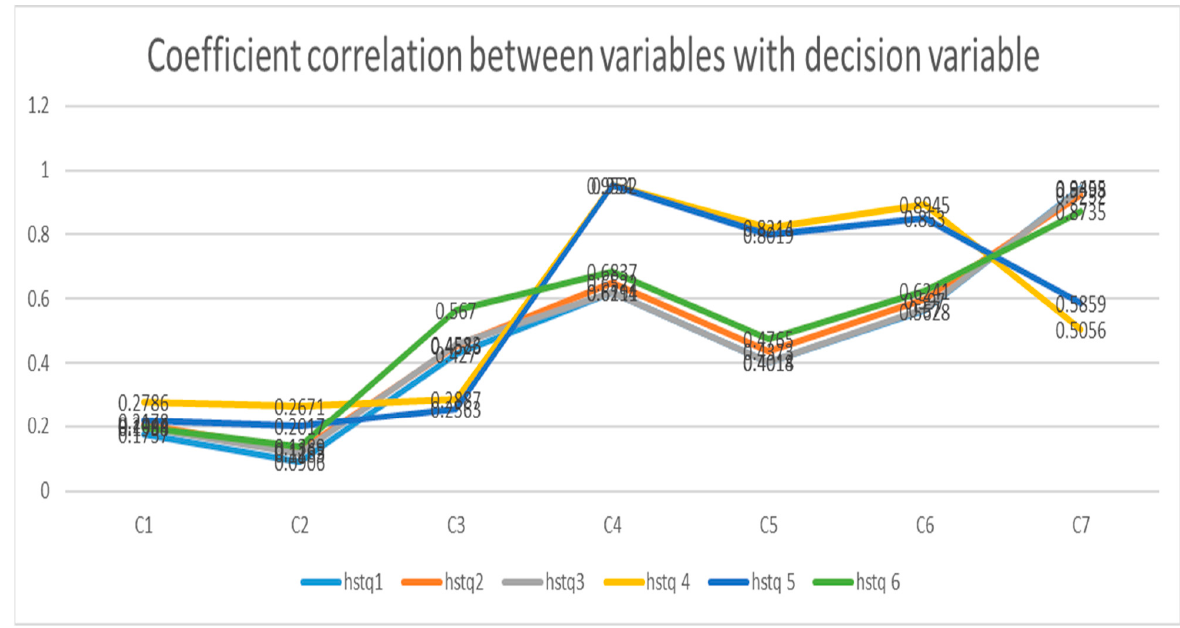
Figure 6. Correlation coefficients between variables and the CC decision variable. Table 5. The top five results with differences in weight vectors. Weight Vectors The Top Three Ranking Meaning